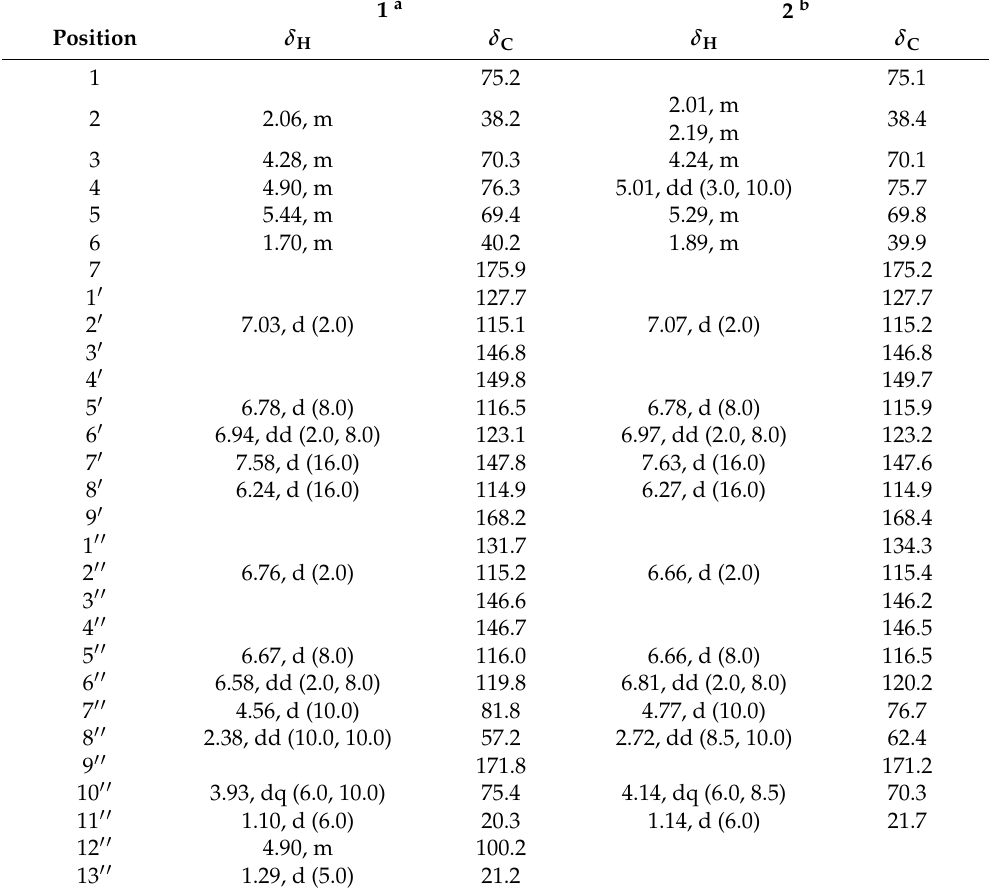
Table 1. NMR spectroscopic data for compounds 1 , 2 in methanol- d 4 ( δ in ppm, J in Hz).